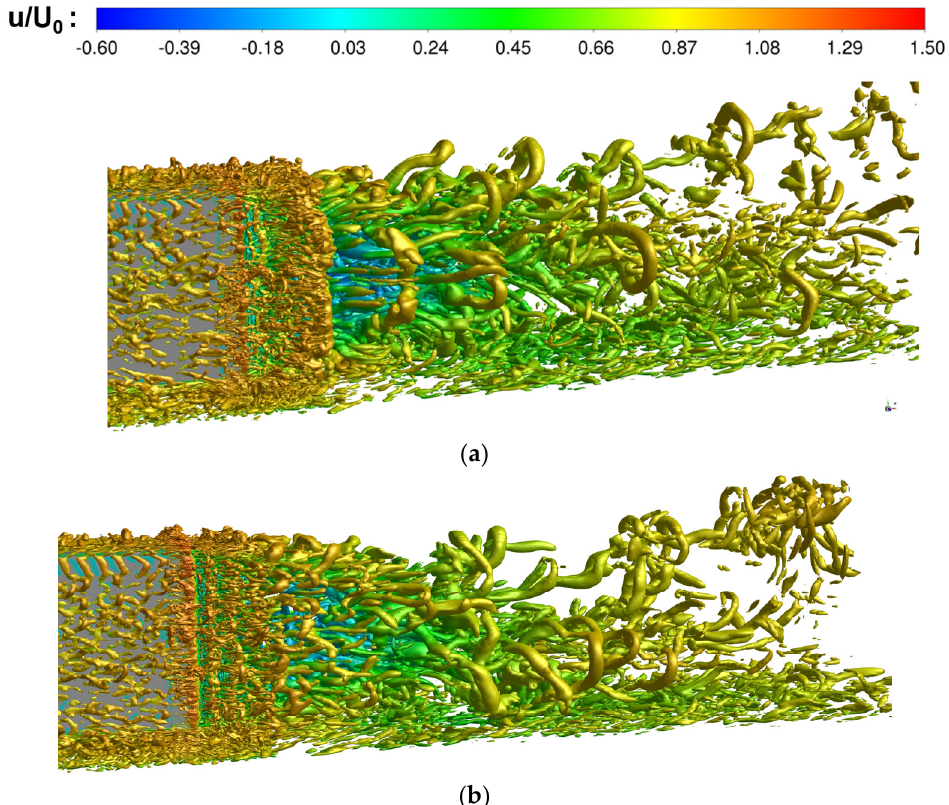
Figure 26. The normalized streamwise contour at the iso-surface Q = 300,000 s -2 with the synthetic jet at different control frequencies. ( a ) fc = 68 Hz; ( b ) fc = 272 Hz.